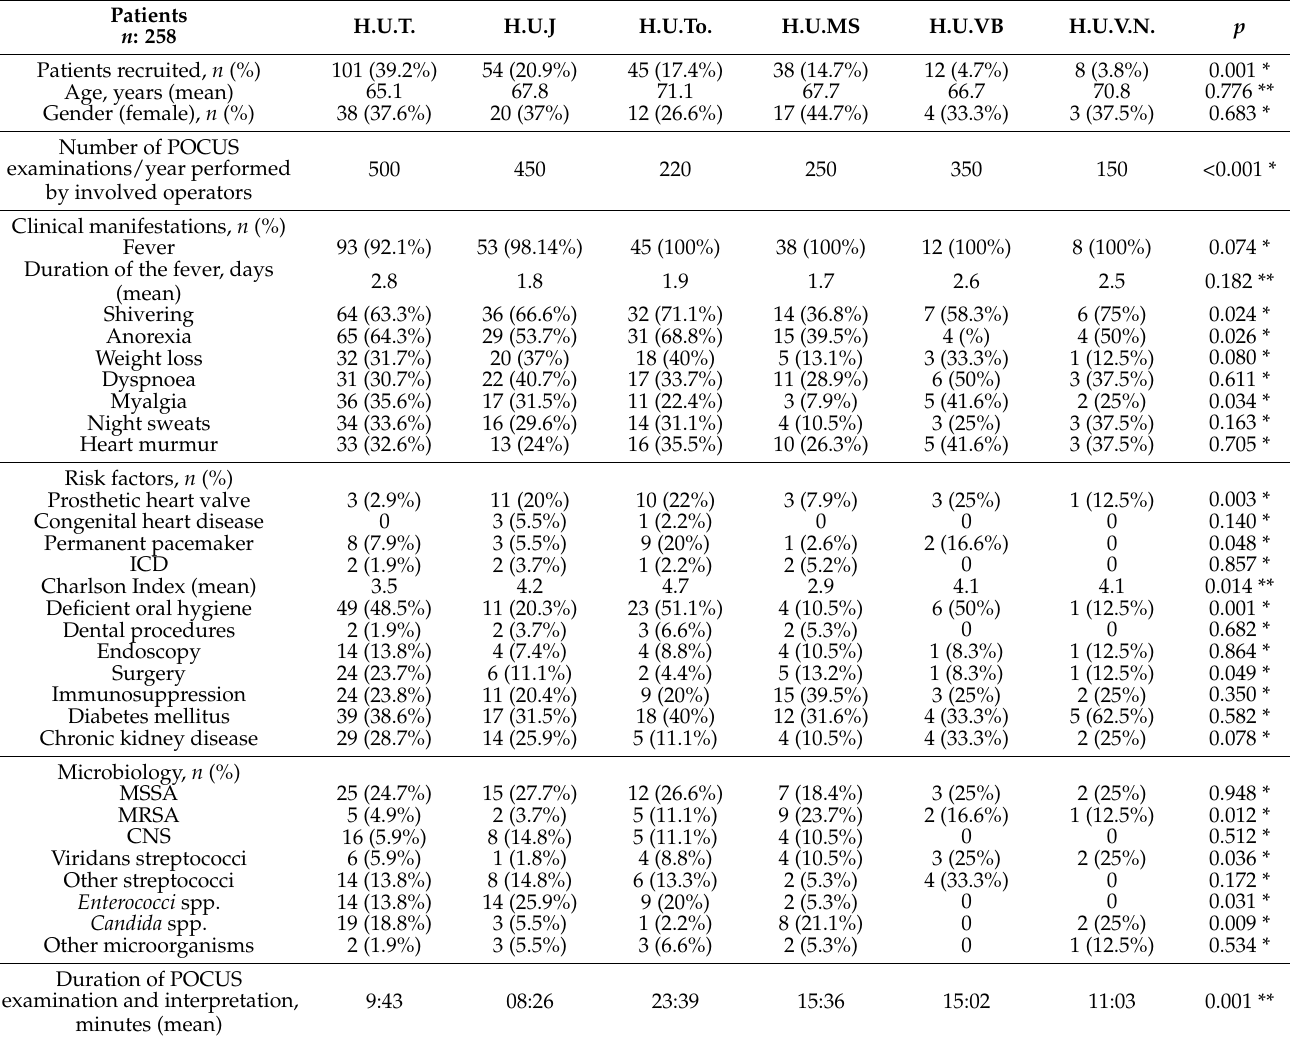
Table 2. Characteristics of patients with bacteremia or